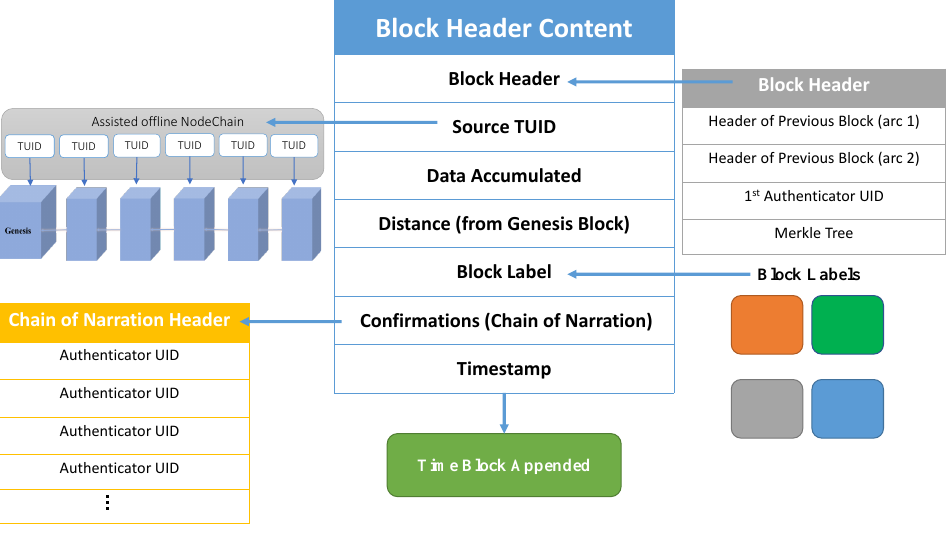
Figure 5. Block Content of Each Zone and its